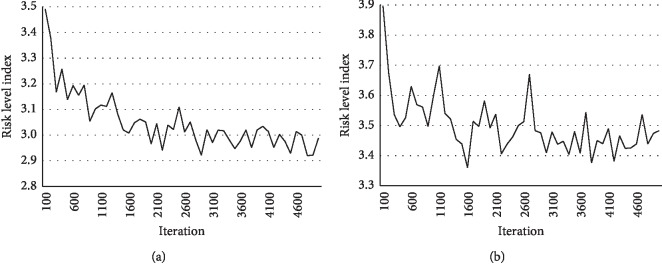
Risk level index for iterations of the learning phase: (a) α=β=0, ALS Ratio=0.83 and (b) α=β=0.4, ALS Ratio=0.83.